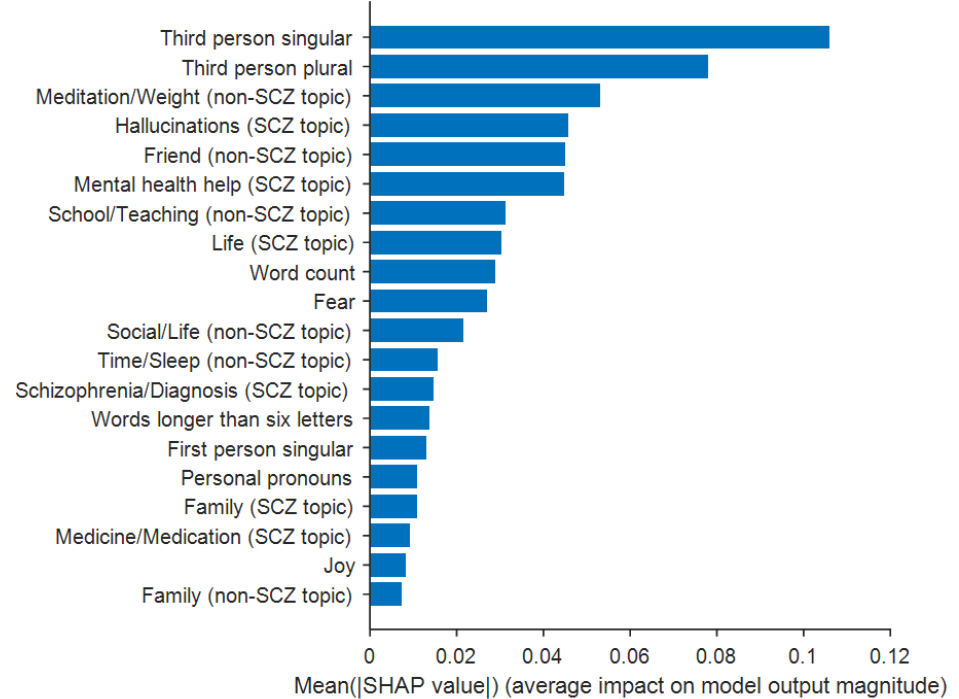
Figure 5. A plot of Shapley values for each feature. Shown is the SHAP feature importance quanti- fied as the mean absolute Shapley value. SCZ = schizophrenia; non-SCZ = non-schizophrenia. Ad- ditional details are provided in Supplementary Table